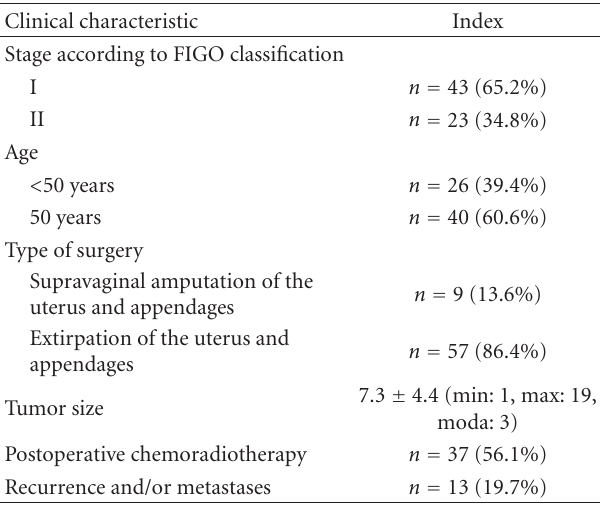
Table 1: Clinical characteristics of patients under